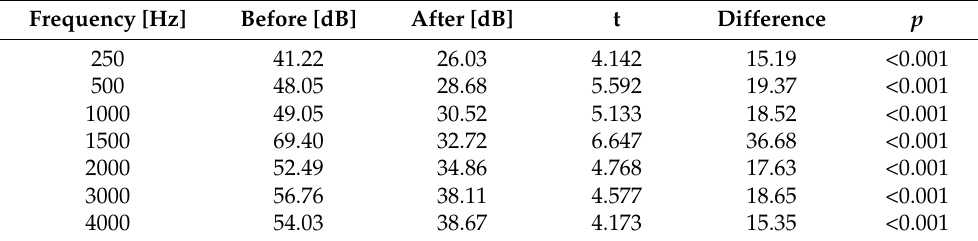
Table 2. Characteristics of hypoacusis—BC.